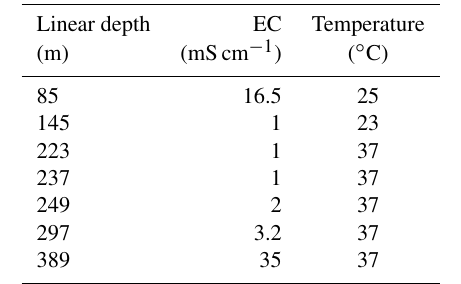
Table 2. Water temperature and electrical conductivity from the exploratory drilling F13 at different depths. This inclined well (40 ◦ NW, 320 ◦ N) is located near the F14 well (Fig.